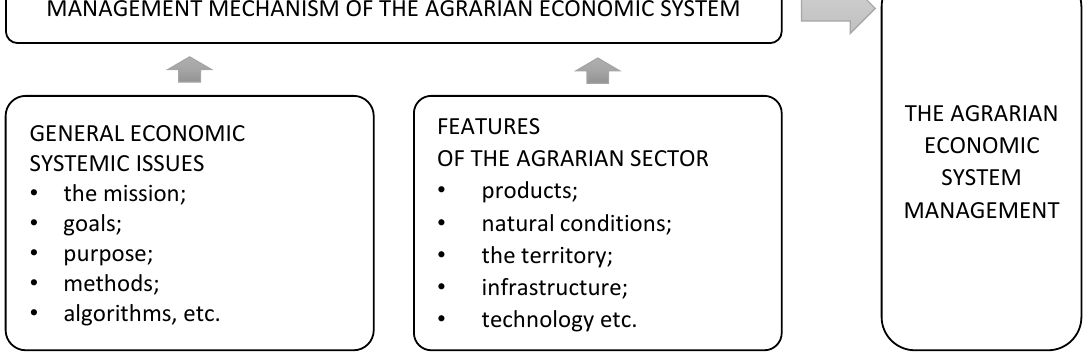
MANAGEMENT MECHANISM OF THE AGRARIAN ECONOMIC